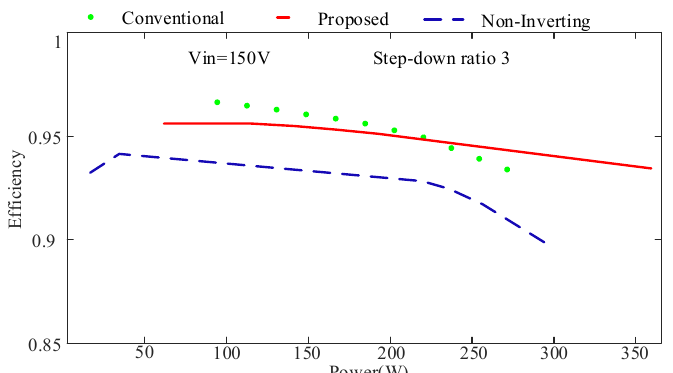
Figure 18. Measured efficiency comparison between the proposed, non-inverting buck-boost, and traditional buck-boost converter at a step-down ratio of